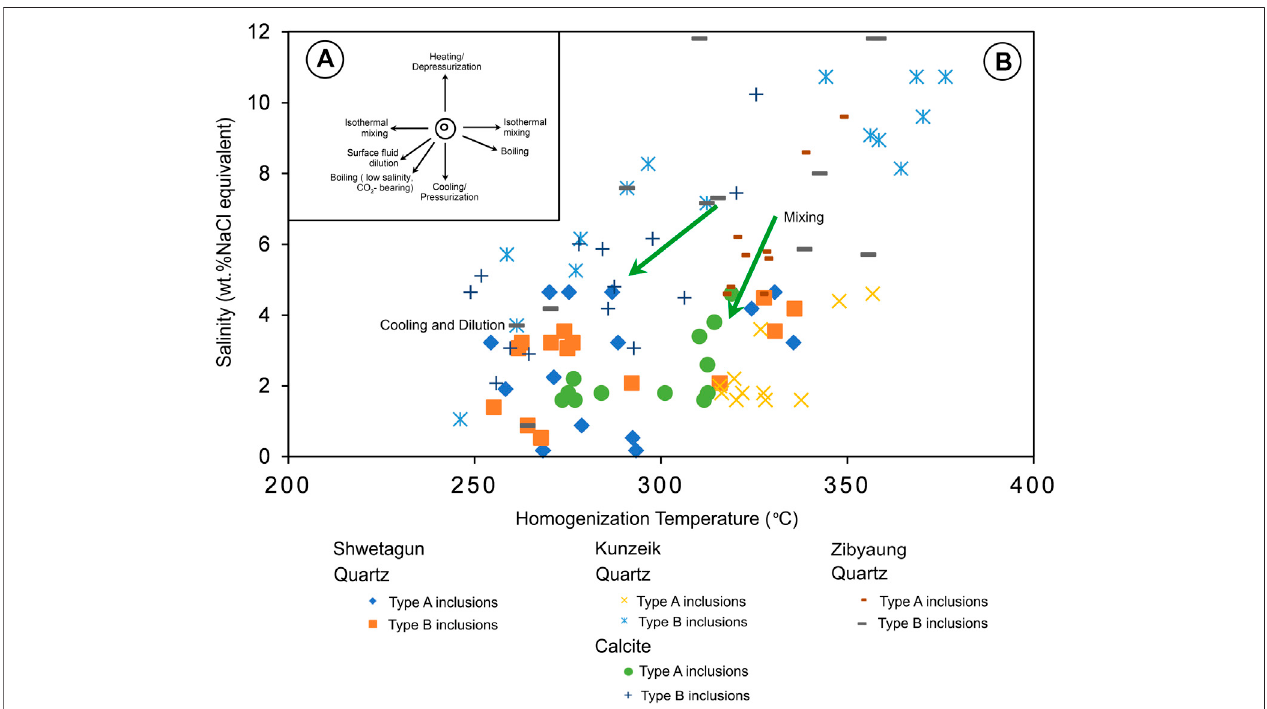
FIGURE 14 | Diagram showing (A) typical trends in the T h ( ° C) – Salinity space caused by various fl uid evolution mechanisms (from Wilkinson, 2001), and (B) variations of homogenization temperature and salinity of fl uid inclusions with hydrothermal fl uid evolution from Shwetagun, Kunzeik, and Zibyaung. The green arrows indicate that both temperature and salinity are decreasing.